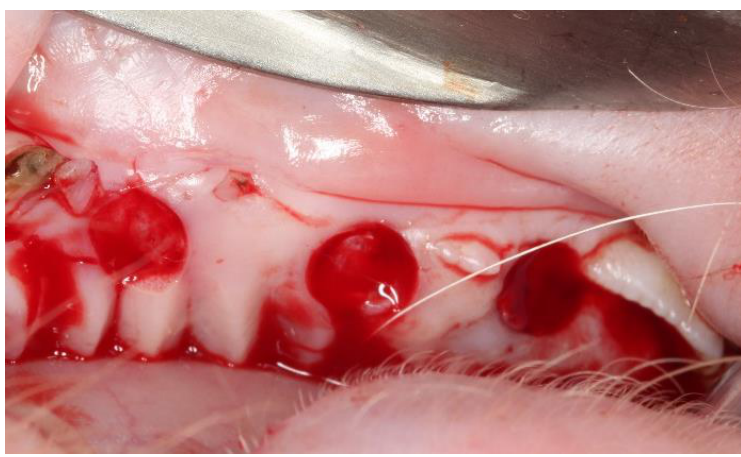
Figure 1. Detail of the surgical beds in an upper